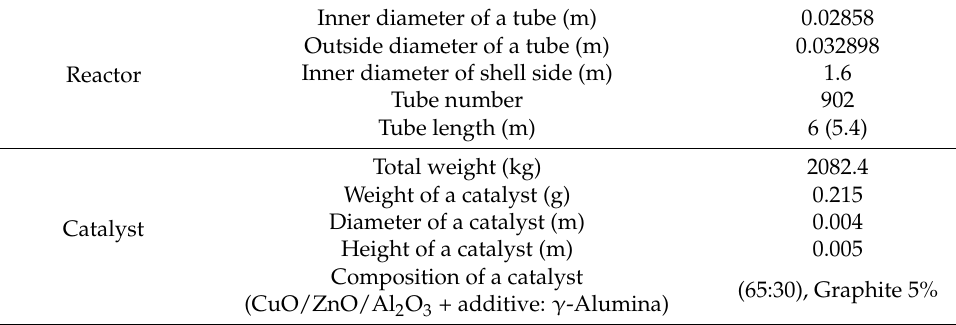
Table 3. Properties of the catalyst and information on the demo-plant scale